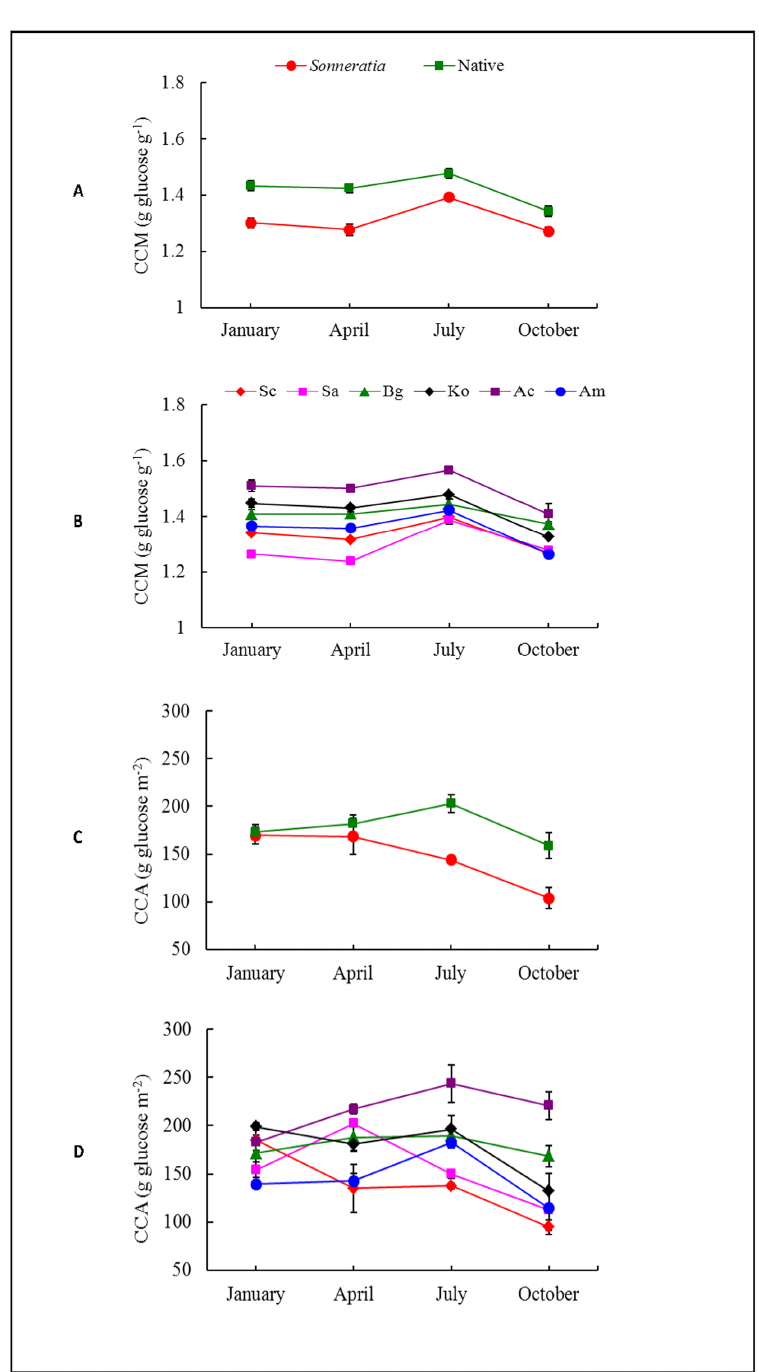
Fig 4. Seasonal dynamics of (A, B) CCM and (C, D) CCA of alien Sonneratia and native mangrove species. Fig 4 legend: Error bars represent ± 1 SE.